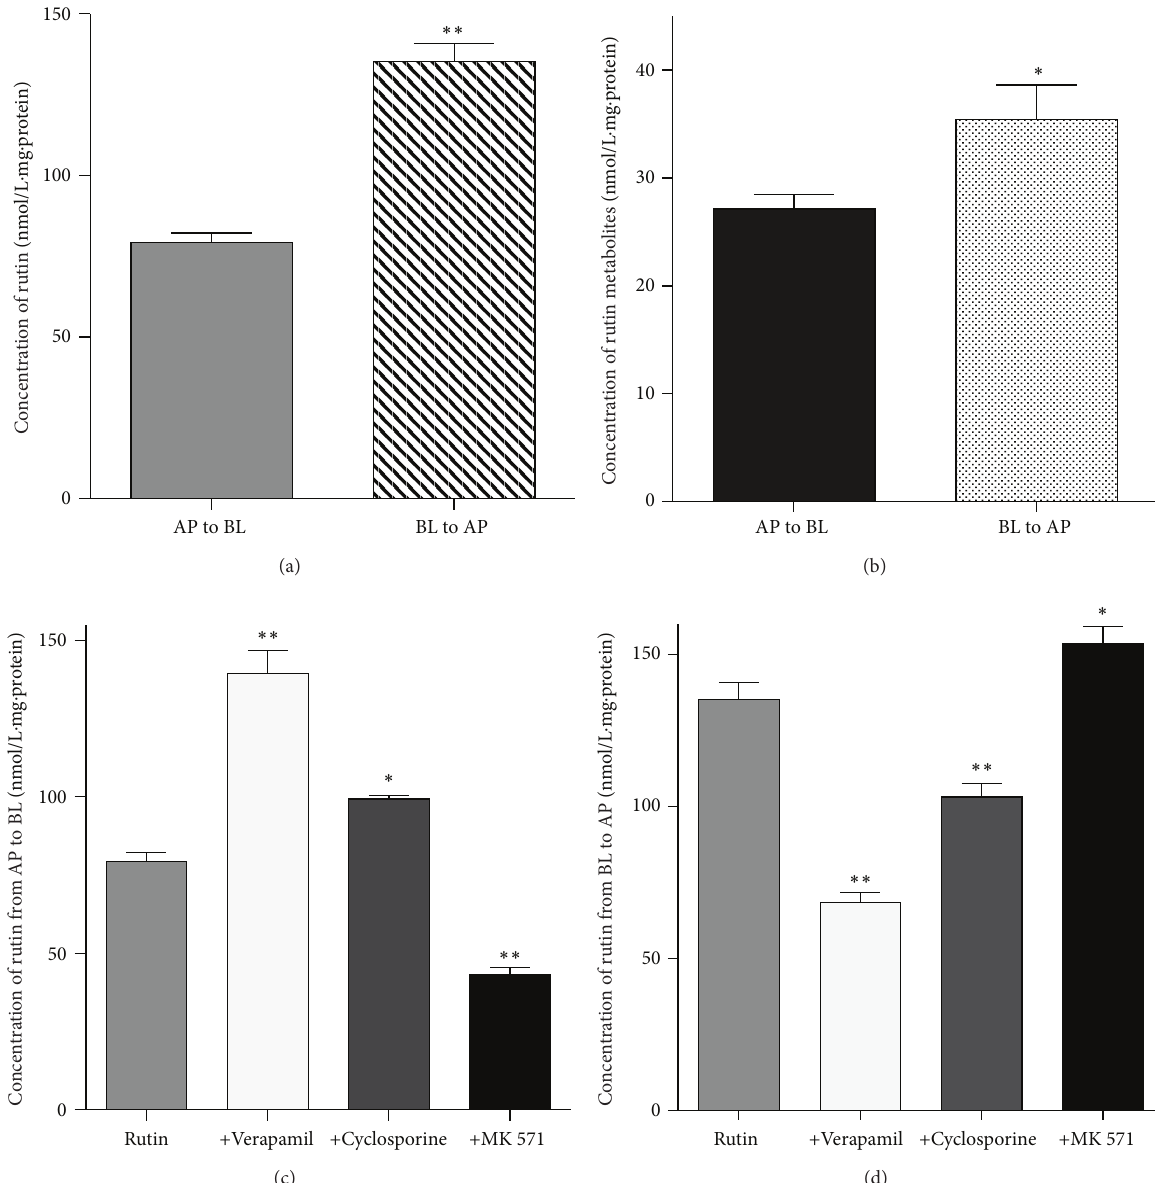
Figure 4: Transport of rutin in Caco-2 Cells. (a) Differences in transport of rutin between the AP to BL direction and the BL to AP direction. (b) Difference in transport of glucuronidated rutin between the AP to BL direction and the BL to AP direction. (c) Transport of rutin in the AP to BL direction in the presence of different inhibitors. (d) Transport of rutin in the BL to AP direction in the presence of different inhibitors. Each value is the mean ± the SD of seven determinations. Statistical significance: ∗∗ 𝑃 < 0.01 ; ∗ 𝑃 < 0.05